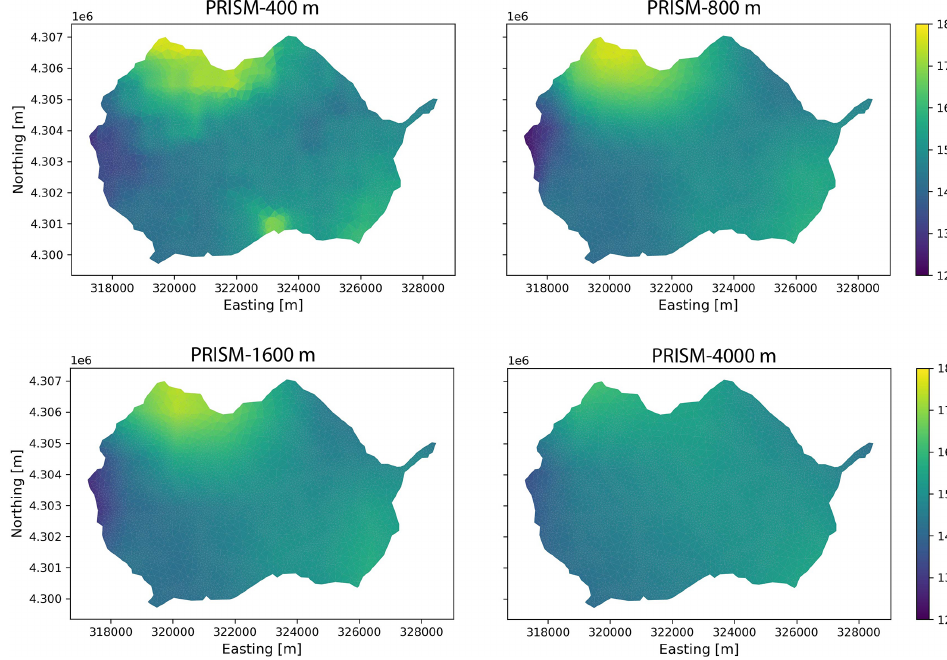
Figure A8. Spatial distribution of precipitation under different spatial resolutions of PRISM on 27 April 2019.